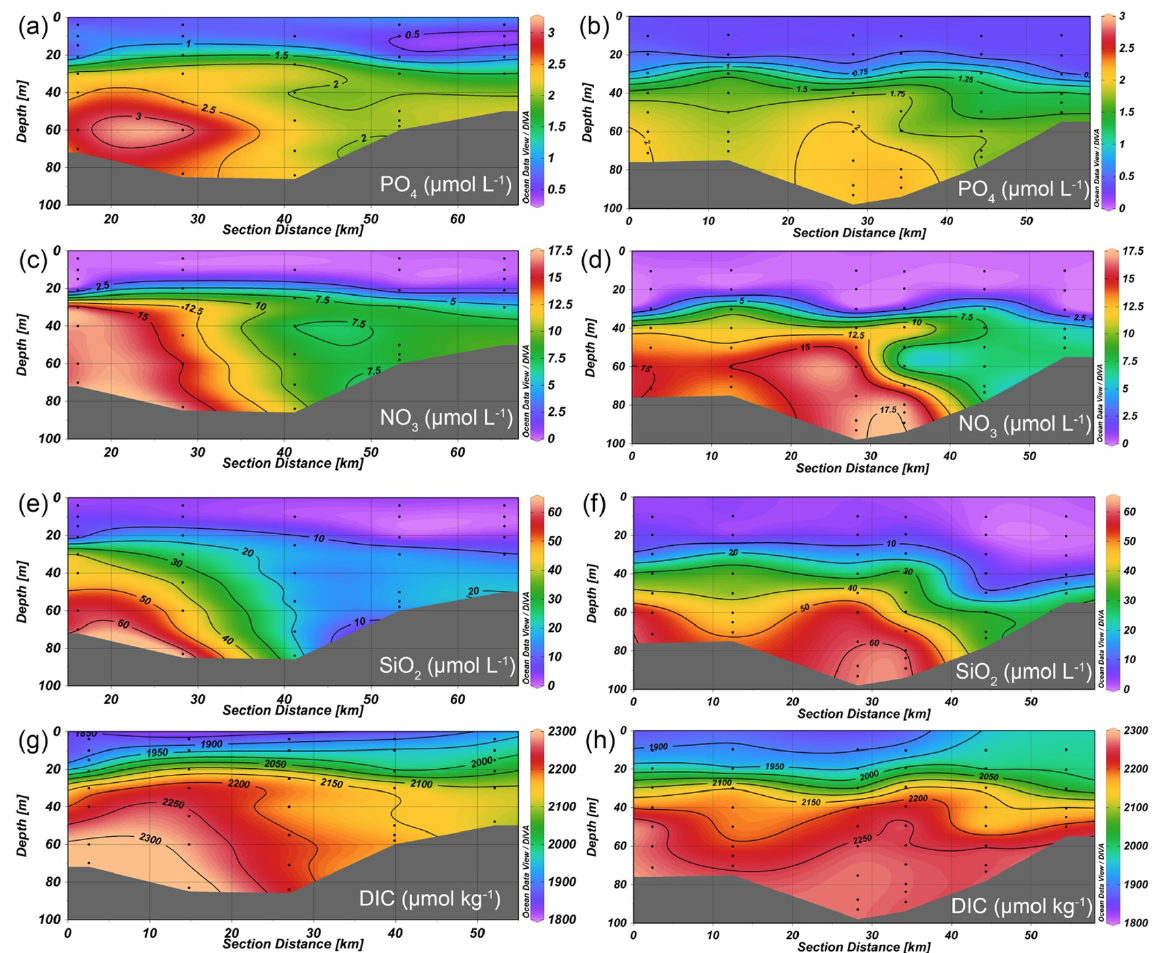
Figure 13. Observed nutrient and DIC sections at latitude about 72 ◦ 20 (cid:48) N (noted as 3 in Fig. 1b) in 2008 (a, c, e, g) and 2014 (b, d, f, h) .